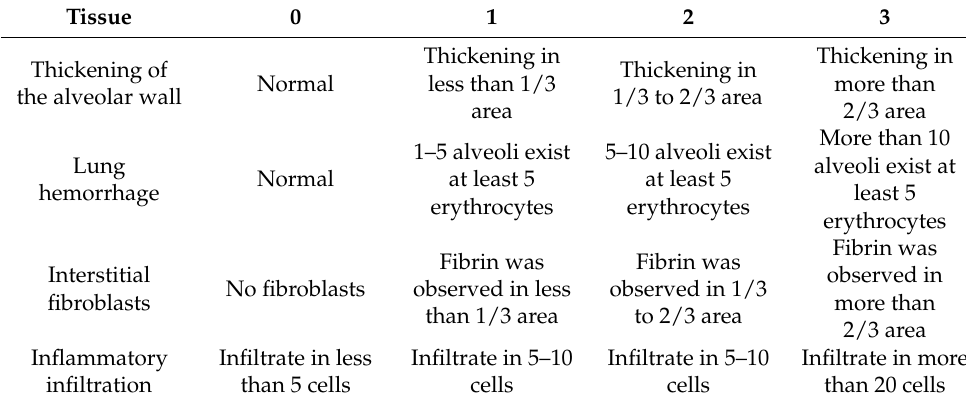
Figure 1. Pretreatment with 1600 kDa hyaluronan (HA1600) protected mice from smoke-induced acute lung injury and inhibited smoke-induced lung edema. Mice were exposed to smoke for 15 min after intratracheal nebulization with HA1600. After 24 h for recovery, mice were sacrificed. ( A ) The lung tissue section stained by hematoxylin and eosin (H&E) (magnification 200 × ). ( B ) The lung injury scores were calculated for randomly selected area of staining sections. ( C ) The lung wet-to-dry weight ratio was determined. Data are represented as means ± SEM ( n = 6). *** p < 0.001 vs. Air group (the control group); ### p < 0.001, # p < 0.01 vs. Smoke group. Table 1. Quantitative histopathology score of lung